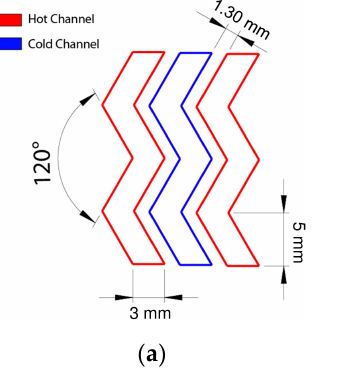
Figure 1. Flow channel geometry: ( a ) conventional zig-zag channel; ( b ) straight channel; ( c ) modified zig-zag channel.